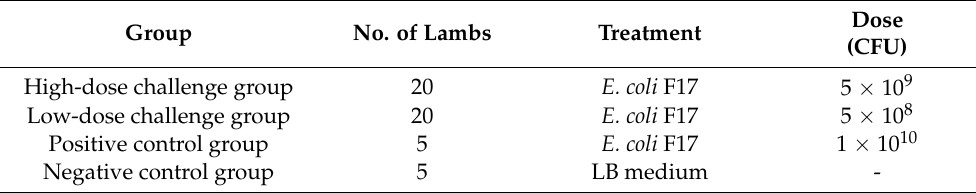
Abbreviations: CFU, colony forming unit.